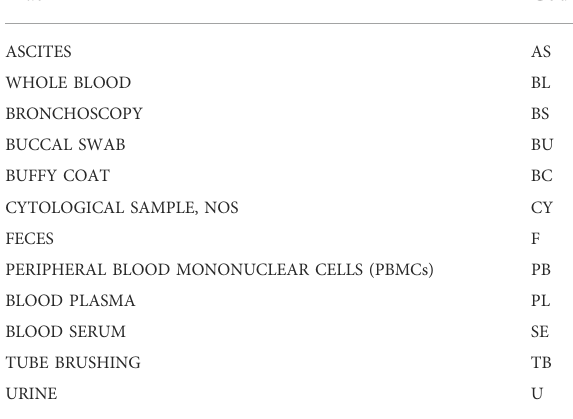
FIGURE 2 Different types of biospecimens collected in a standard biobank. PMBC, peripheral blood mononuclear cells.